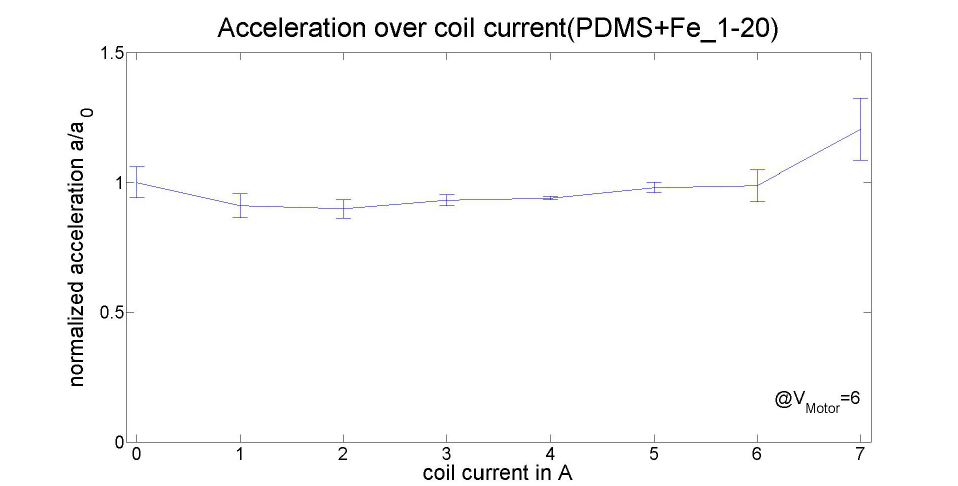
Figure 7. Results - standard material.